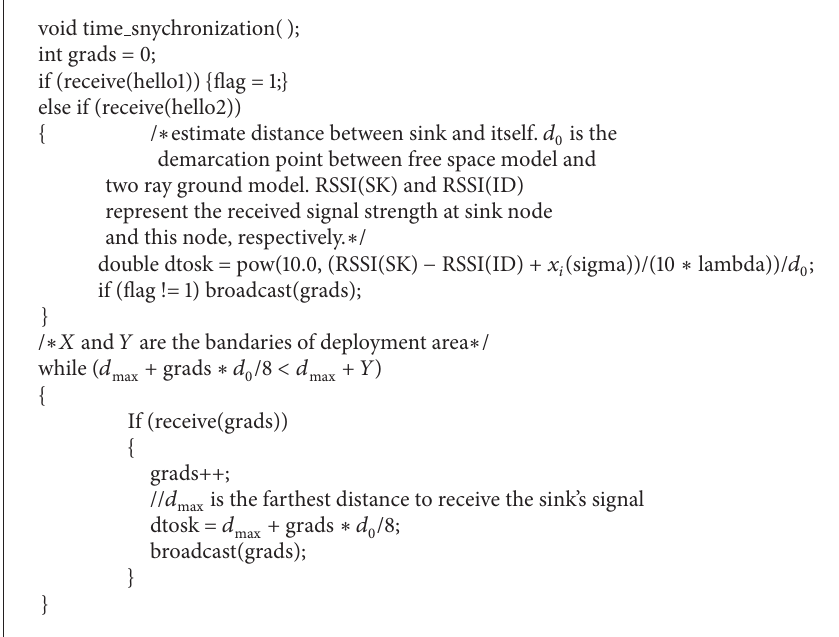
Algorithm 1: The pseudocode implementation of the